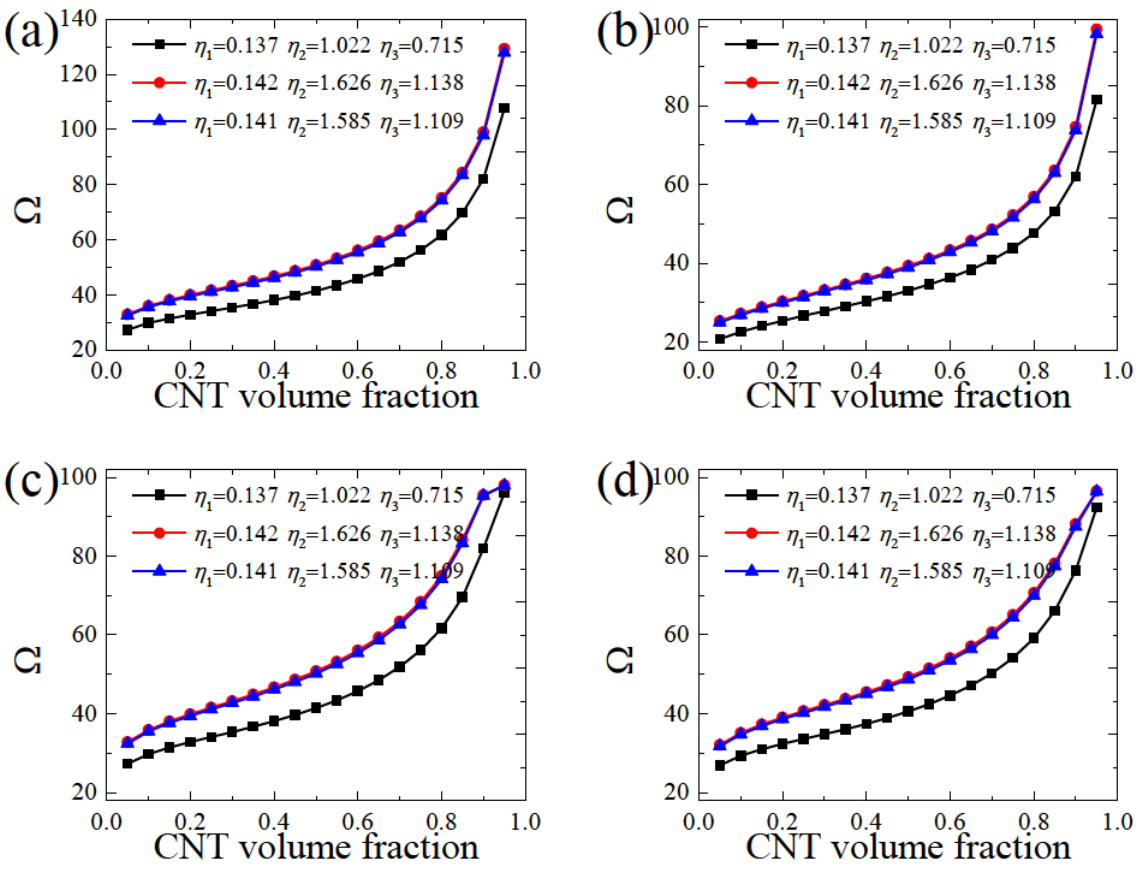
Figure 11: Variation of the fundamental frequency parameters Ω versus the CNT volume fraction V tcnt for FG-CNT reinforced composite panel with various boundary conditions: (a) CCCC; (b) SSSS; (c) E 1 E 1 E 1 E 1 ; (d) E 3 E 3 E 3 E 3